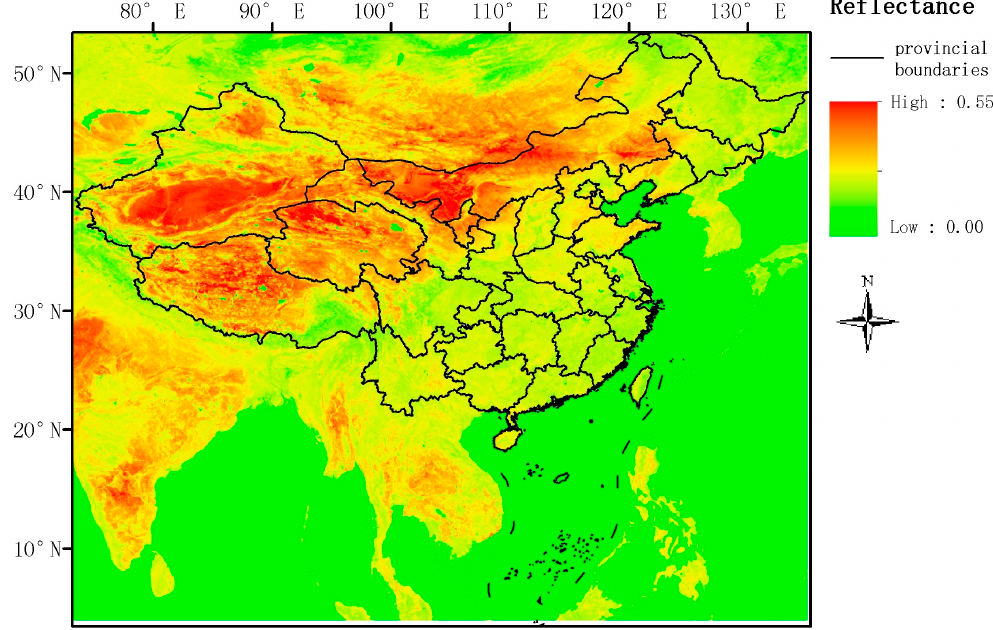
Figure 10. Yearly mean reflectance for China. The processing method for Figure 10 are presented in Section 2.4.